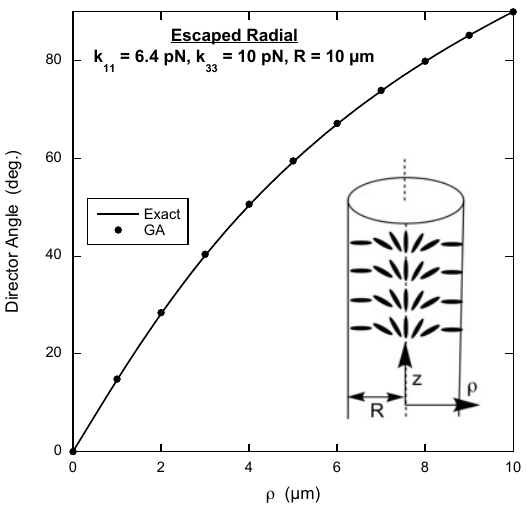
Figure 4. Director angle for the escaped radial director configuration in a cylinder. Inset: schematic of the cylinder. The director angle is measured from the z -axis in the ρ z-plane. Black circles: genetic algorithm results; black line: exact